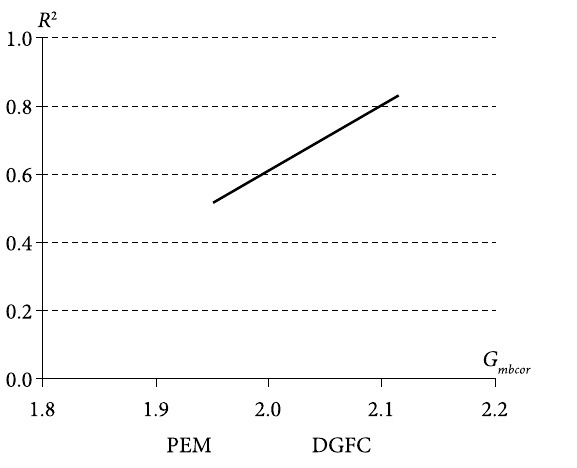
Fig. 14. R -square values of the correlation P CE = aW + b